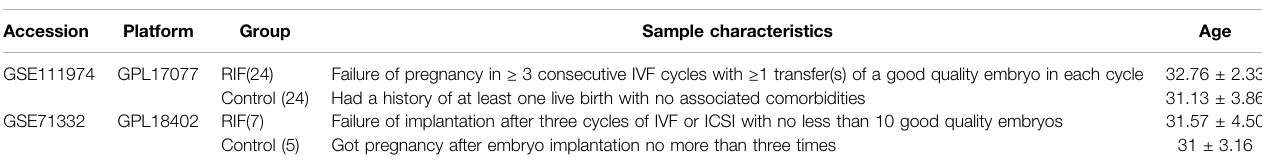
TABLE 1 | Characteristics of mRNA and miRNA expression pro fi